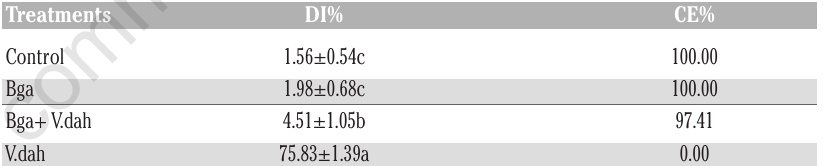
Table 2. Disease index and control effect of plants subjected to different tested treat- ments.